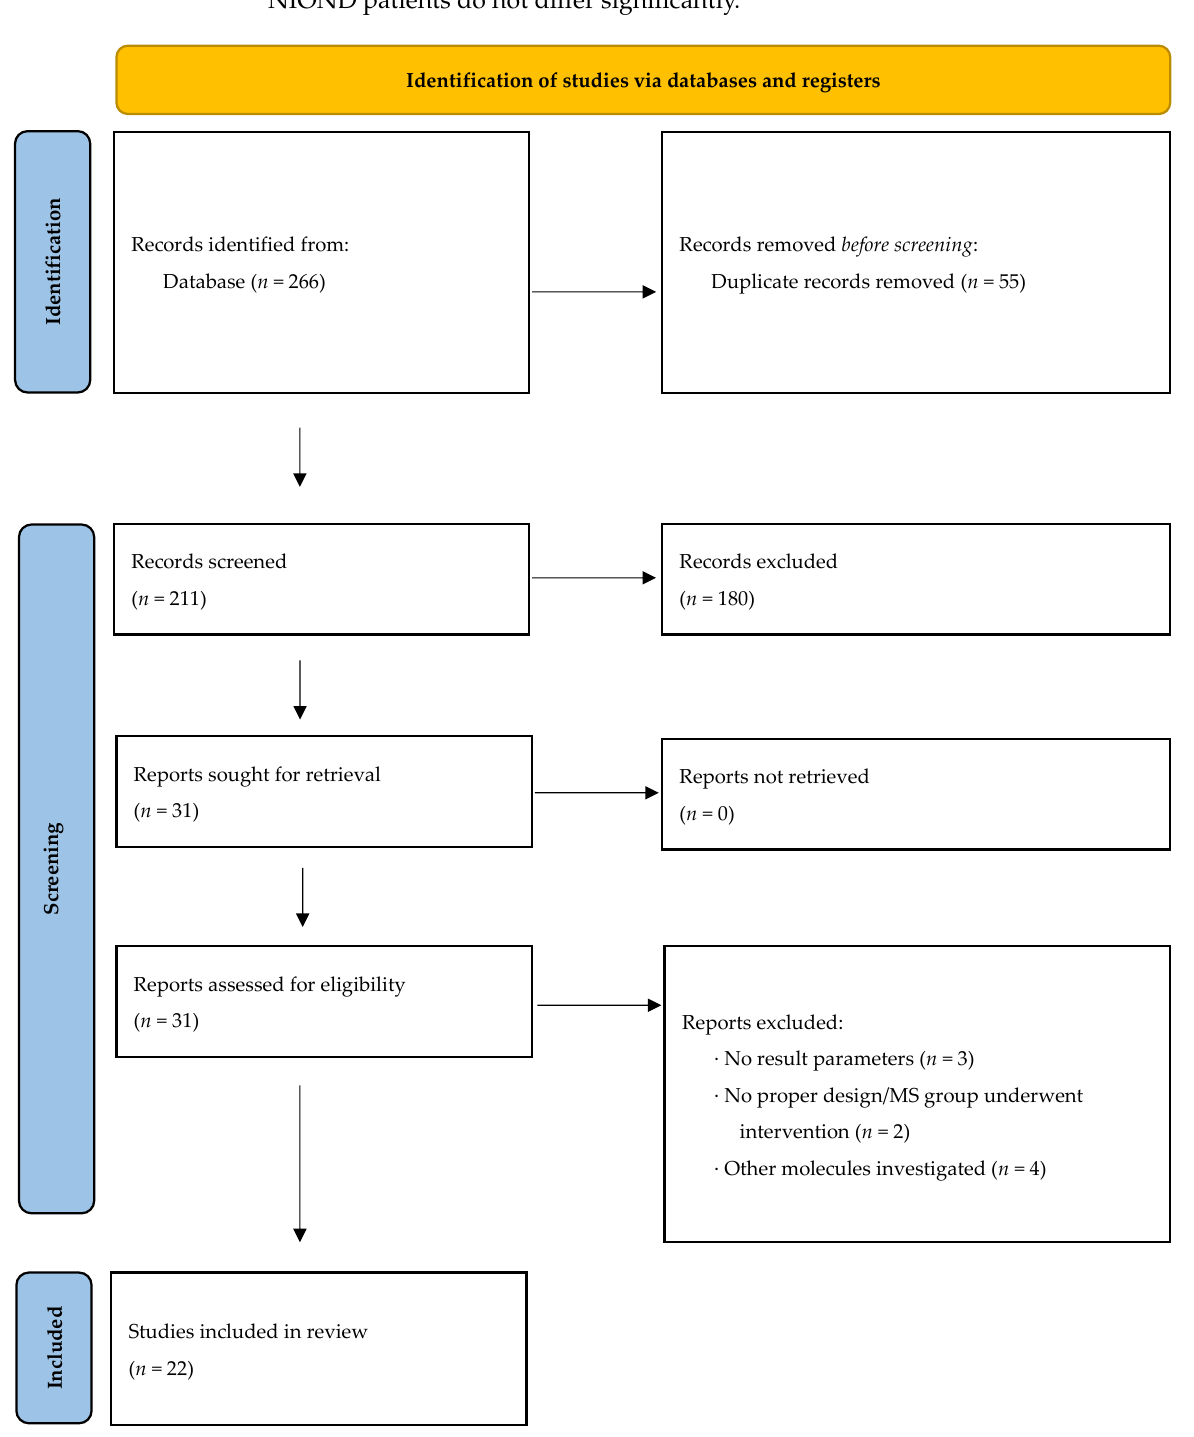
Figure 1. Preferred reporting items for systematic reviews and meta-analyses (PRISMA) study flow diagram.